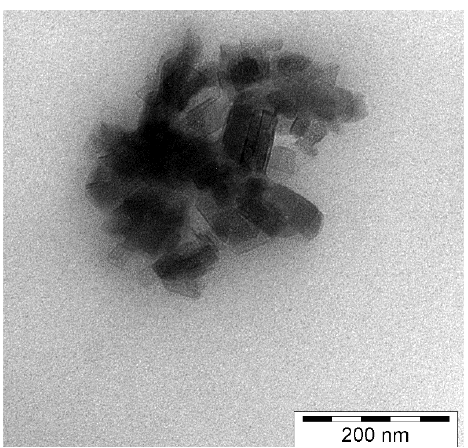
Figure 1. Transmission electron microscopic (TEM) picture showing Disperal ® 40 (Sasol, Germany) particles in a polyethylene (PE) matrix. The primary crystallite size of this BA is at about 40 nm.